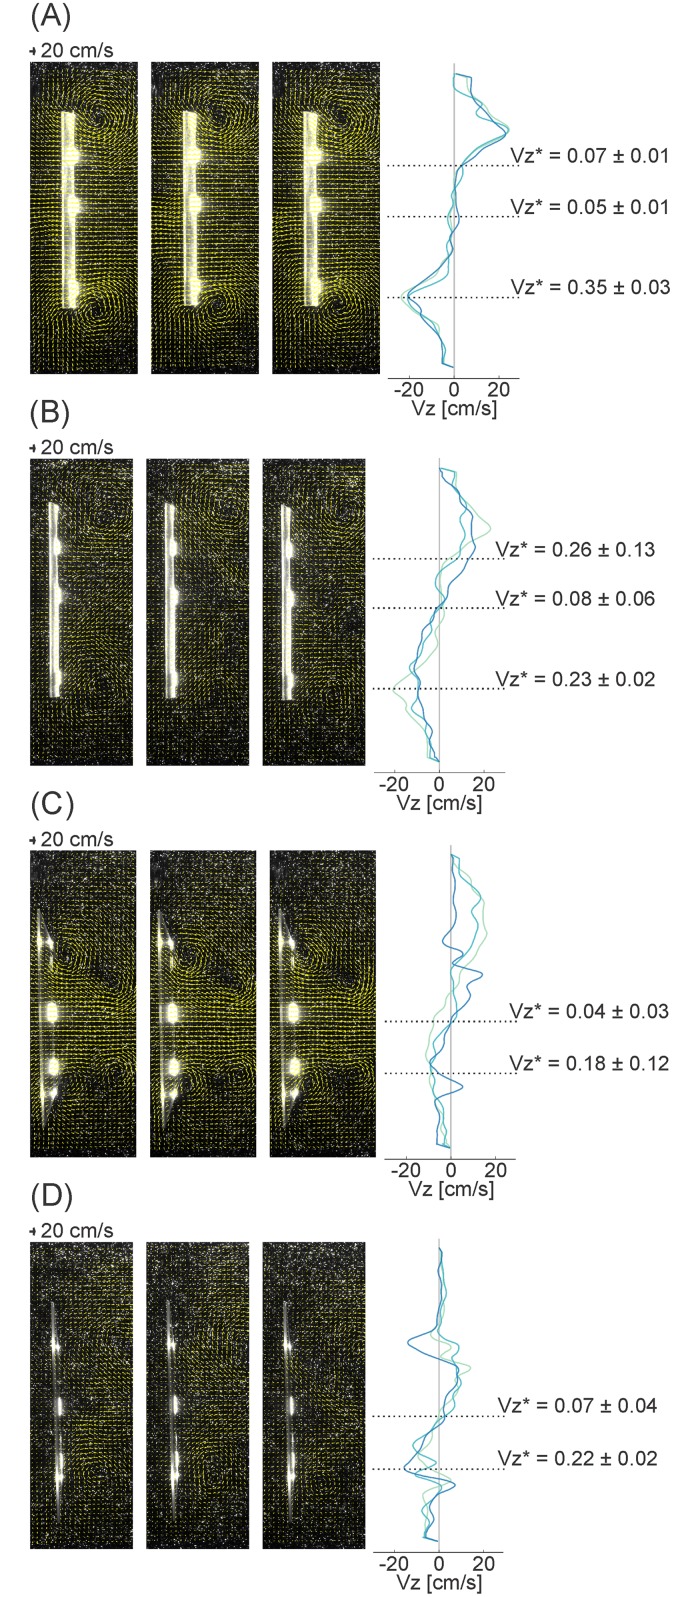
Velocity vector fields in the transverse plane.Velocity vector fields in the transverse plane as the foils approach direction reversal, for 1.5 Hz actuation frequency, 1.5 cm heave amplitude, and 30 cm/s oncoming flow (the conditions used for 3D testing). The foils move toward the left. Vertical velocities (Vz) were taken along a vertical line immediately to the right of the foil. Bright spots represent either the edges of the foil or the strips of fluorescent paint. Colors in velocity traces represent different trials. (A) Rectangular foil, 0° angle of attack program. (B) Rectangular foil, heaving program. (C) Tail-shaped foil, 0° angle of attack program. (D) Tail-shaped foil, heaving program. Vz*—Vz normalized by the total velocity at the measurement location, plus or minus standard deviation. Rect—rectangular foil. Tail—tail-shaped foil.